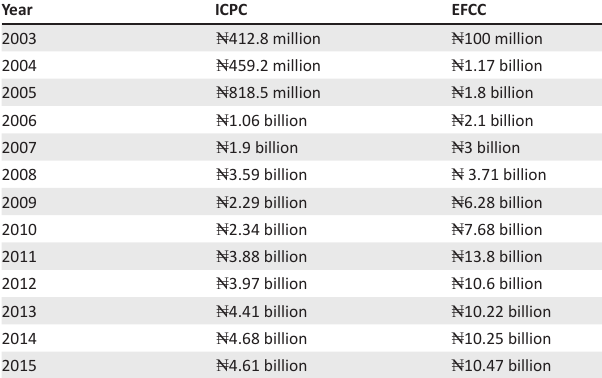
TABLE 1: A comparative analysis of the allocations to the Independent Corrupt Practices and Other Related Offences Commission and the Economic and Financial Crimes Commission from 2003 to